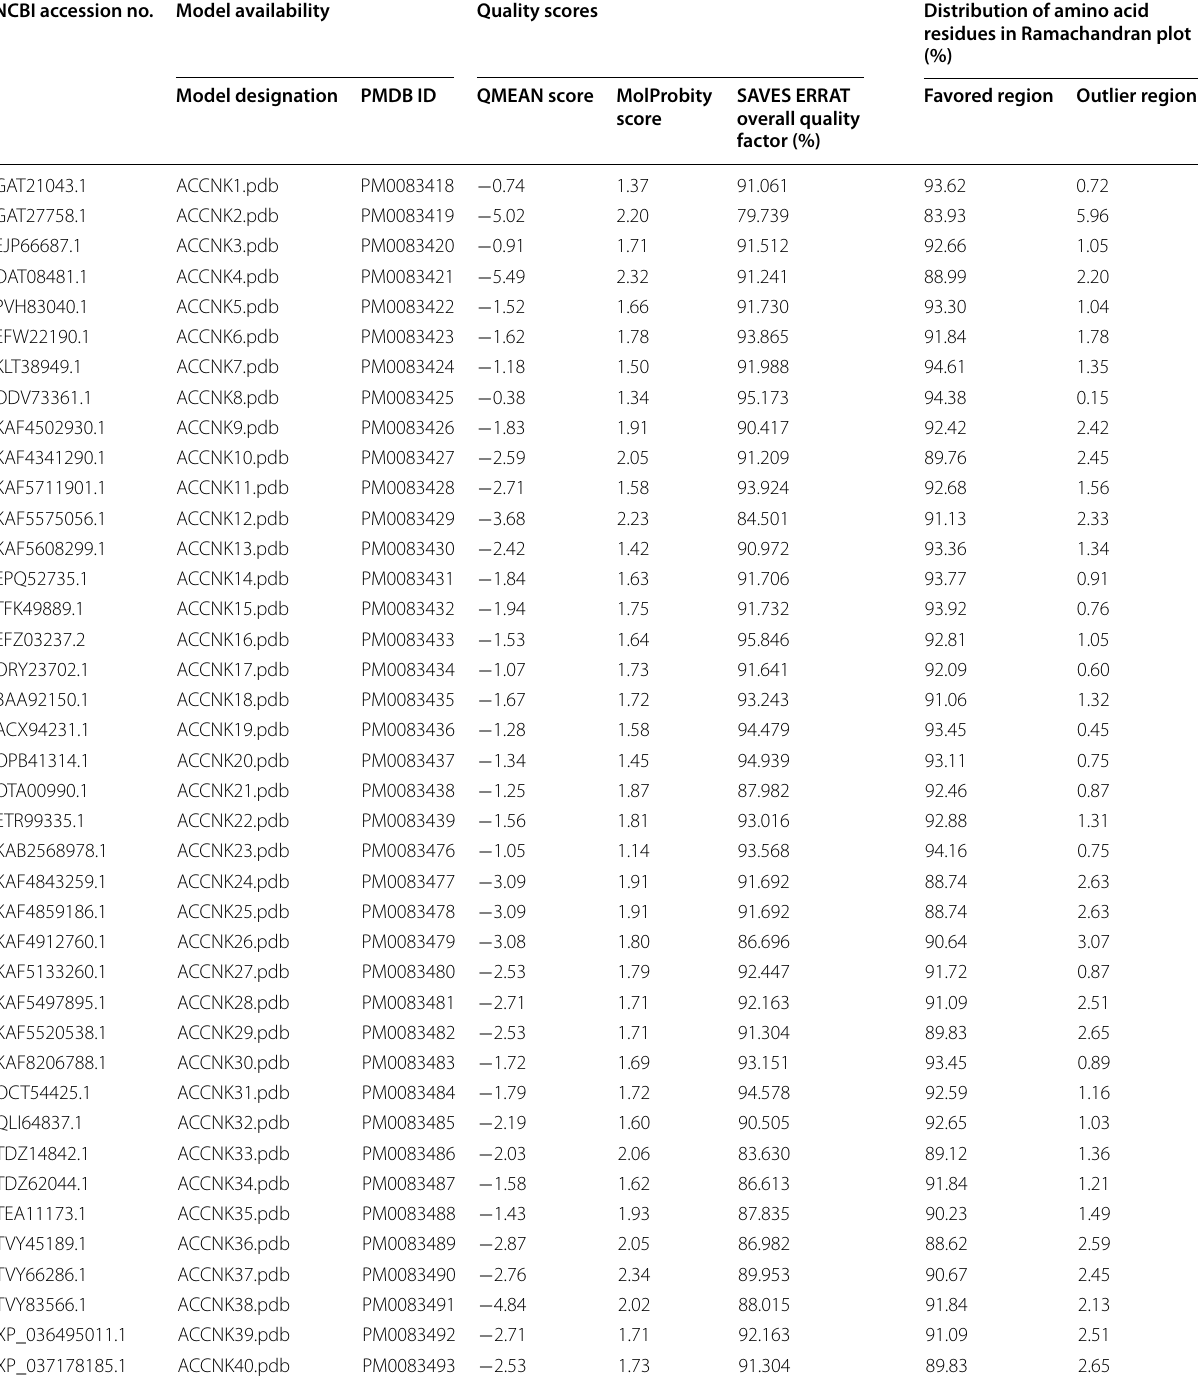
Table 2 Model availability and quality assessment of built fungal ACCD protein models NCBI accession no. Model